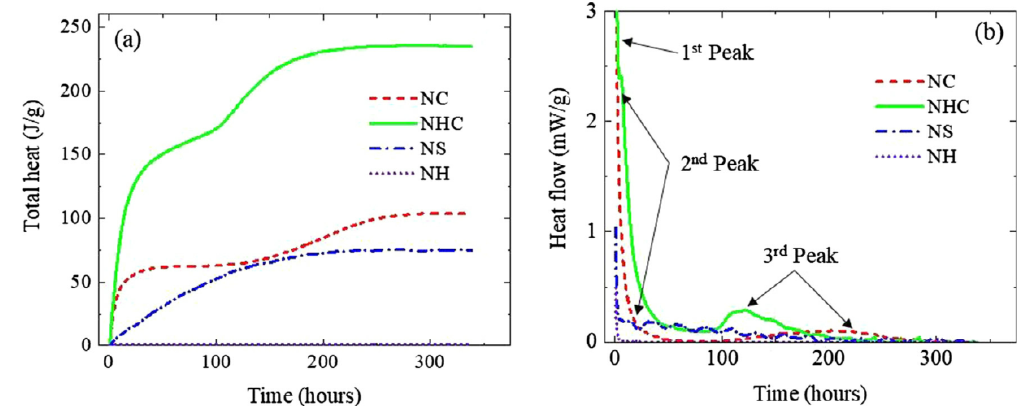
Figure 6. ( a ) Total heat released and ( b ) heat flow graphs for chemically activated γ− C 2 S systems [87], adapted from [87], with permission from Elsevier, 2021.